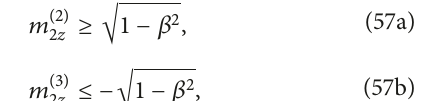
Figure 7: M¨ossbauer absorption spectra (solid lines) of 57 Fe nuclei in the ensemble of ferrimagnetic particles with 𝛽 = 0.5 calculated in the slow-relaxation regime for different values of the effective energy barrier 𝐾𝑉/𝑘 𝐵 𝑇 in the absence of the quadrupolar interaction ( 𝑞 = 0 ). Partial absorption spectra corresponding to the sublattice magnetizations M 1 (thin solid lines) and M 2 (dotted lines) are also